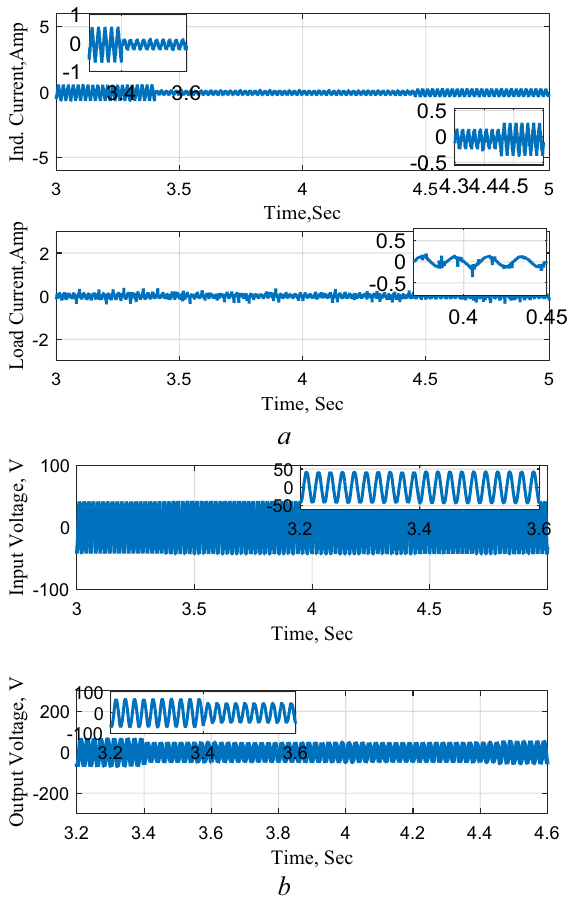
Figure 19. Response to a step change in the reference voltage. ( a ) Inductor and output currents, ( b ) input and output